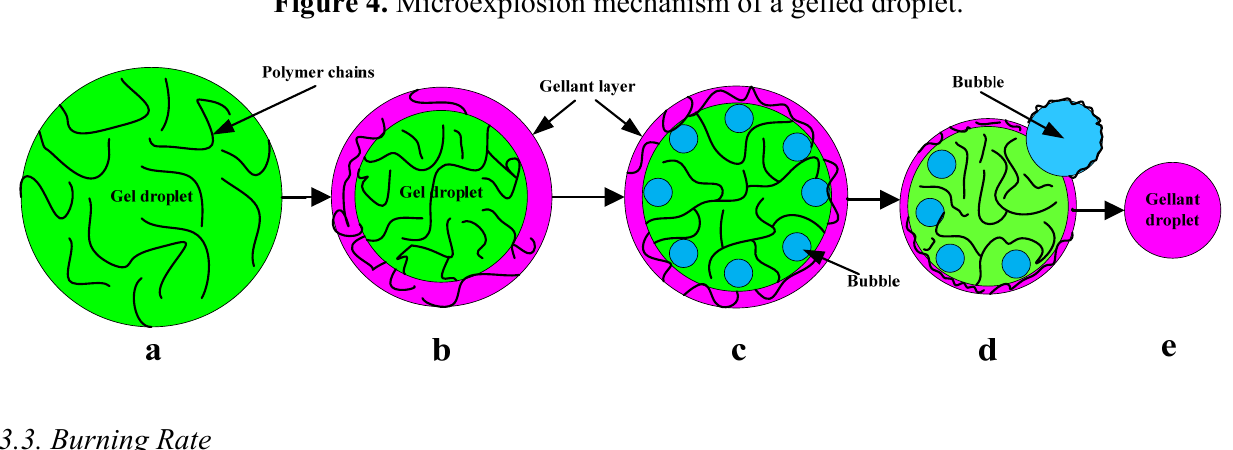
Figure 4. Microexplosion mechanism of a gelled